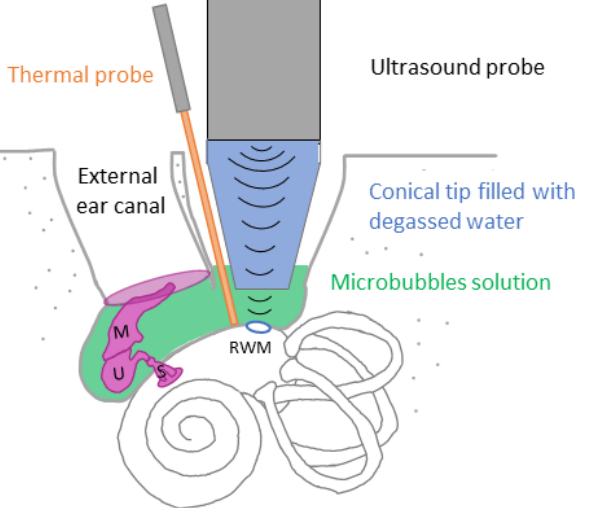
Figure 3. Diagram of the sonoporation of RWM. After surgical mastoidectomy, MBs solution (in green) was injected in the middle ear and ultrasound were applied using an ultrasound probe connected to a degassed water-filled cone. Promontory temperature was measured before and after sonoporation using a thermal probe (in orange). M: Malleus, U: Uncus, S: Stapes, RWM: Round window membrane.